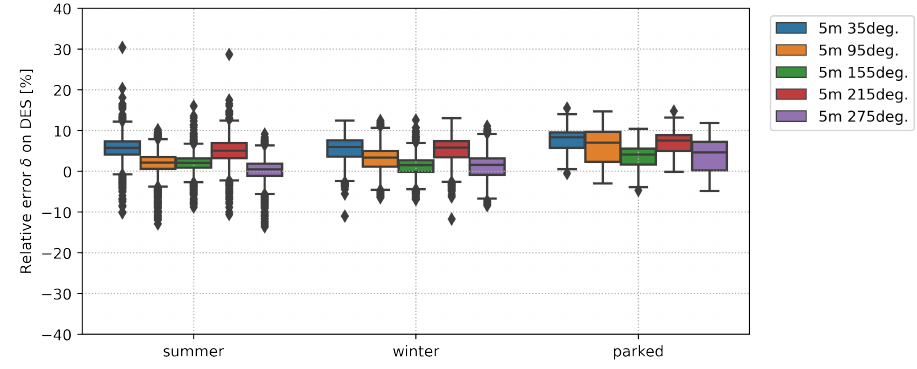
Figure 14. Relative error on DES per sensor on the TP for each validation